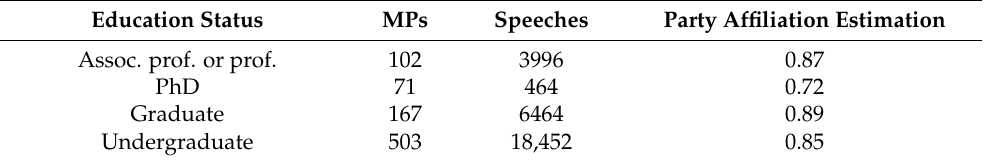
Table 5. Impact of the education status on the party affiliation classification.